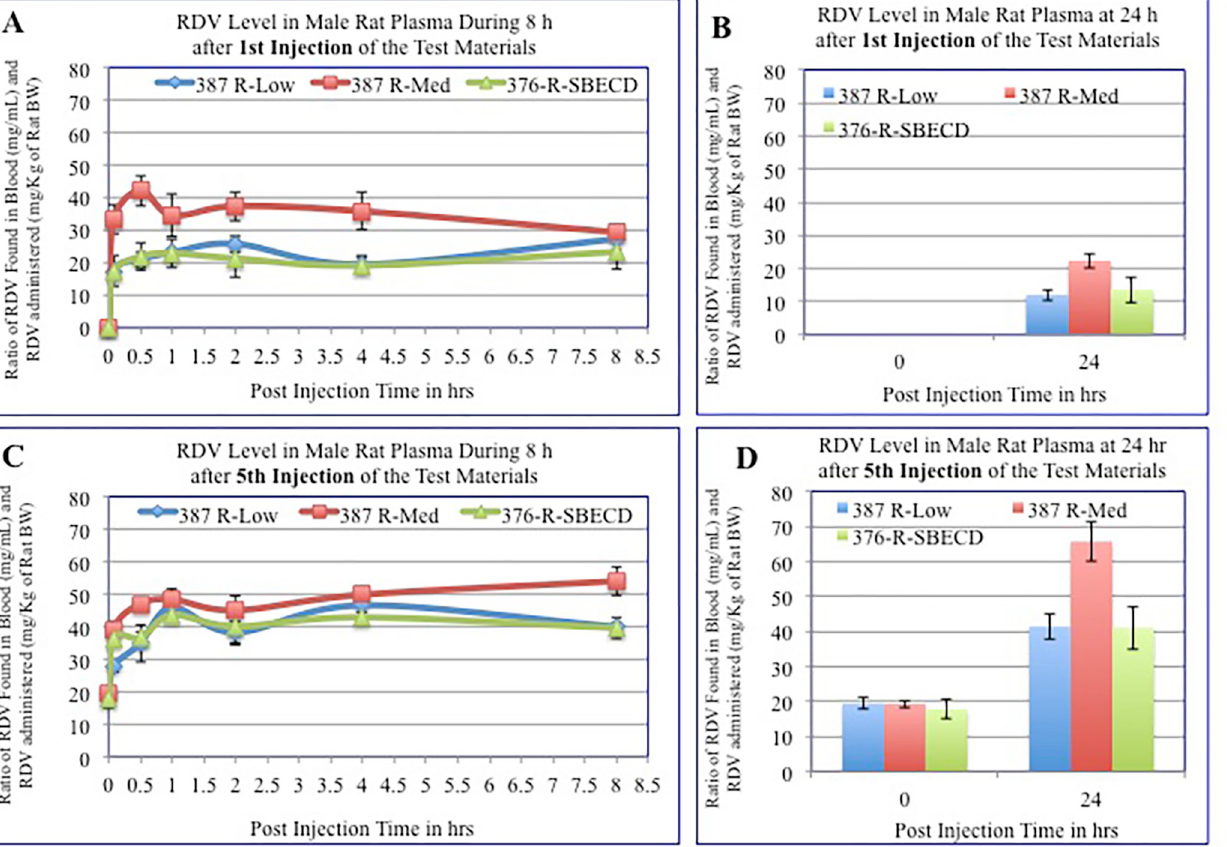
Fig 4. Protection efficiency of NV-CoV-2 encapsulation of RDV (NV-CoV-2-R) from plasma mediated degradation in vivo .